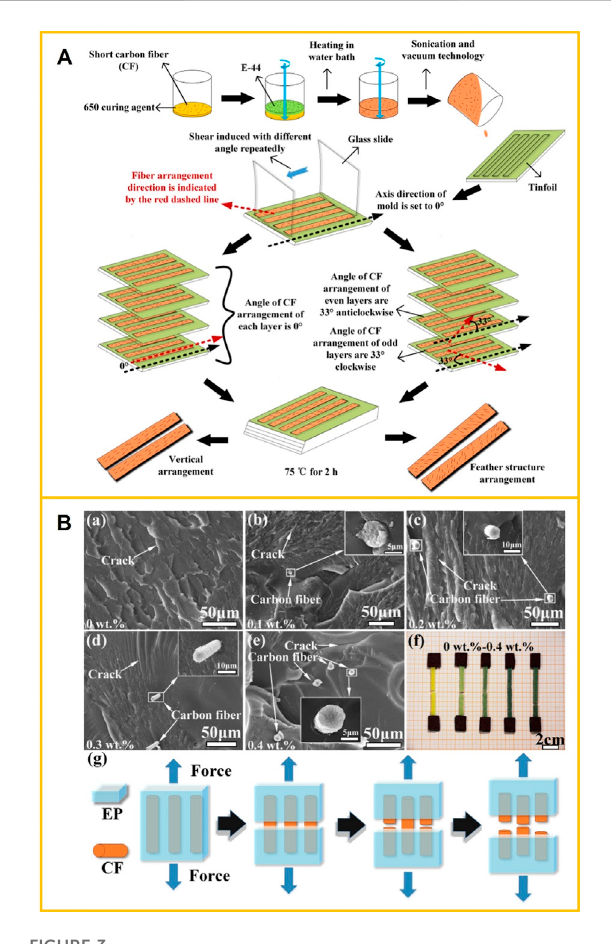
FIGURE 3 (A) Manufacturing process of carbon fi ber reinforced epoxy resin composites. Reprinted with permission from (Liang et al., 2021). Copyright 2021 IOP Publishing Ltd. (B) Tensile fracture appearance of short carbon fi ber reinforced epoxy resin composites with various carbon fi ber content (a) 0 wt%, (b) 0.1 wt%, (c) 0.2 wt%, (d) 0.3 wt%, (e) 0.4 wt%, (f) tensile test samples and (g) tensile resistance mechanism. Reprinted with permission from (Liang et al., 2021). Copyright 2021 IOP Publishing